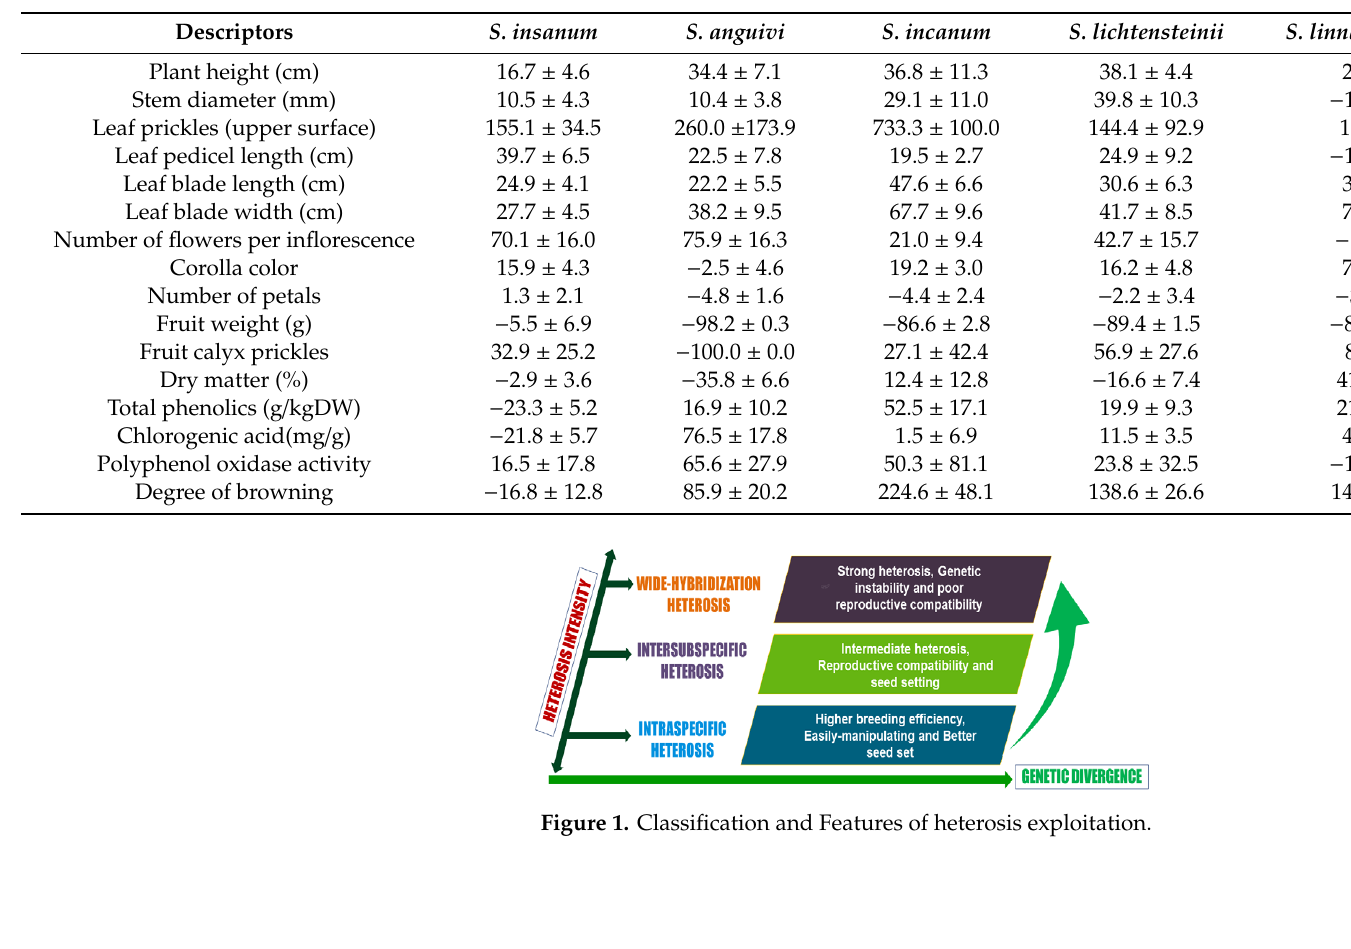
Table 1. Heterosis in the eggplant using wild relatives as the male parents taken from Kaushik et al. [35,37].